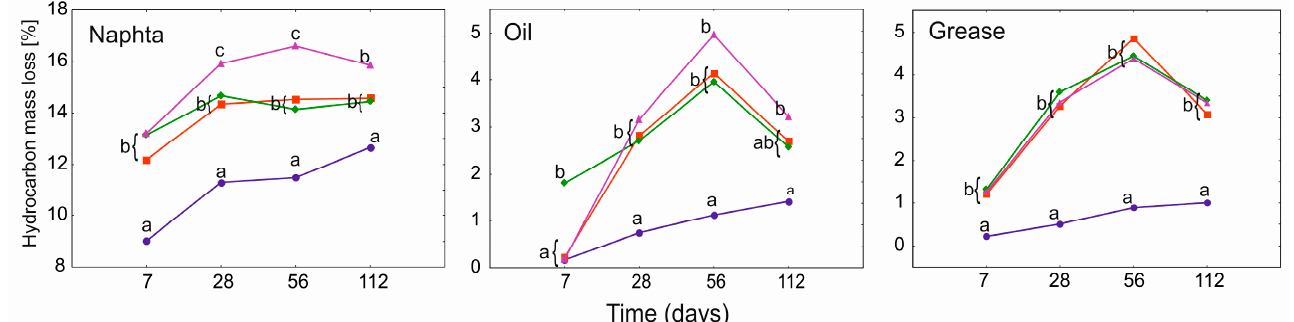
Figure 2. GLMM for mean hydrocarbon mass loss of heavy naphtha, lubrication oil, and grease for PGA treatment (blue and circle—PGA 0 , red and square—PGA 1 , green and diamond—PGA 1B , violet and triangle—PGA 10 ) and time (days). The different letters indicate the pairwise differences according to Duncan pairwise test. Mean values, standard error, and confidence intervals are included in Supplementary Material Table S1.